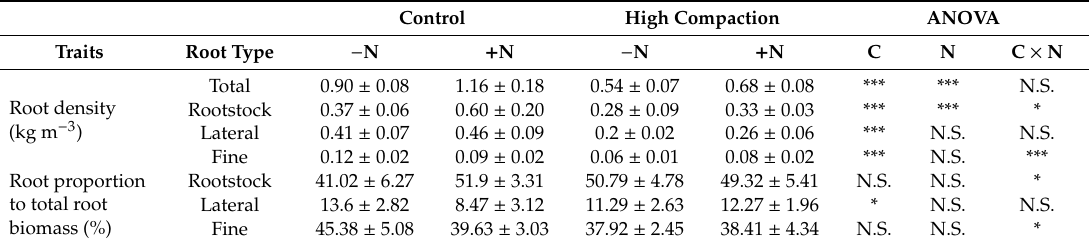
Table 2. Mean value ± SE of underground responses to soil compaction without N loading ( − N) and with N loading ( + N) and the results of ANOVA (Compaction: C; N loading: N). ***: p < 0.001; *: p < 0.05; N.S.: not significant. ( n = 5).